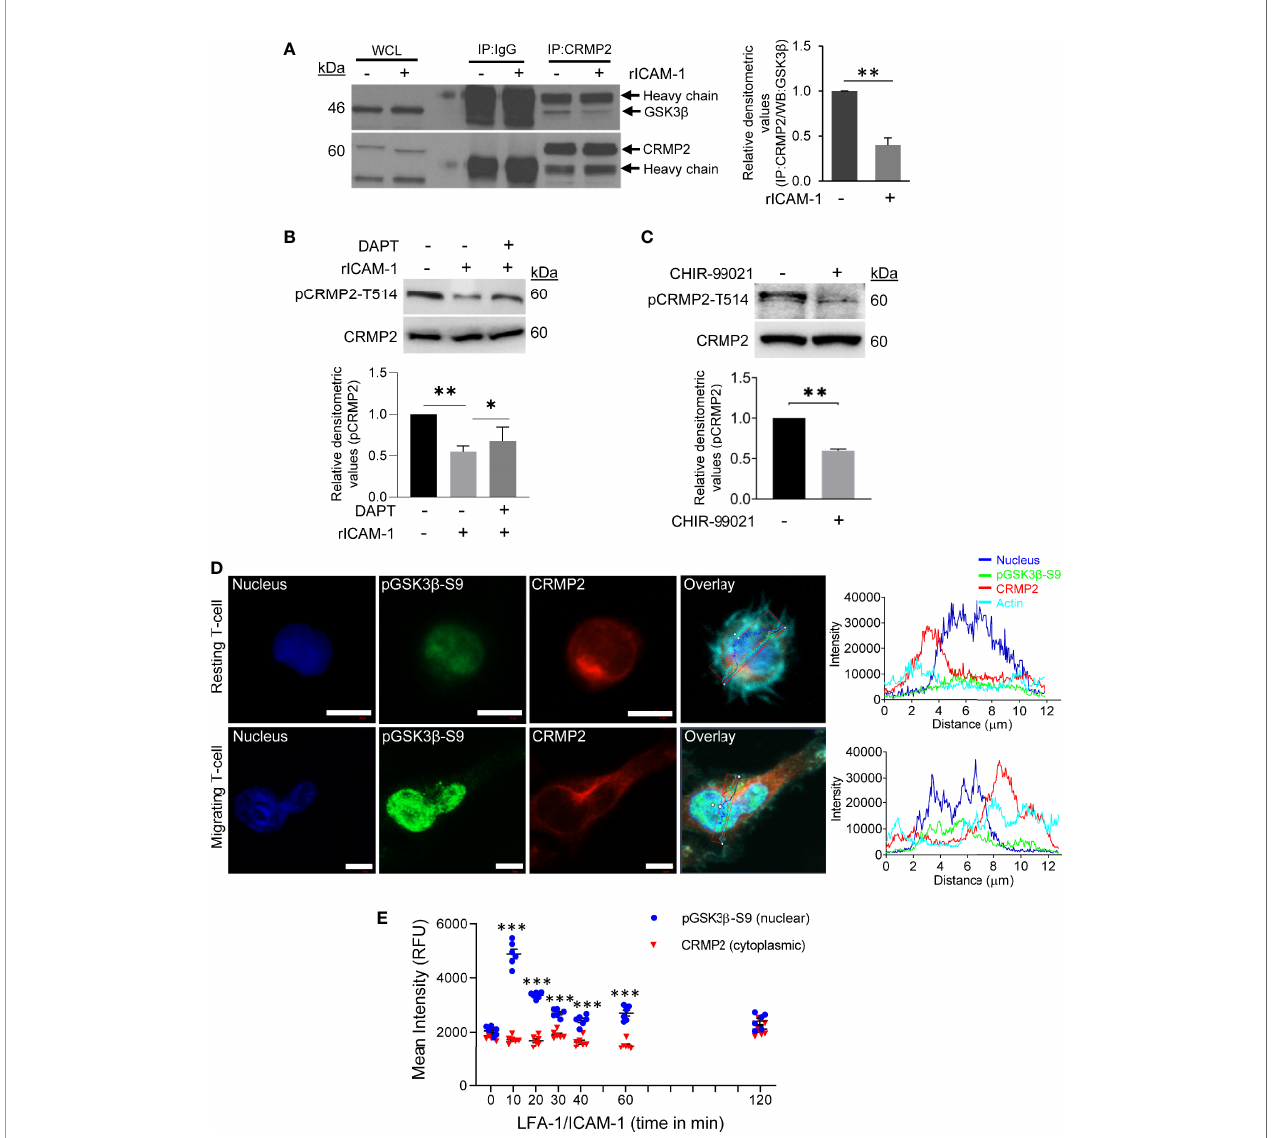
FIGURE 4 | GSK3 b -CRMP2 interactions in motile T-cells. (A) Human primary T-cells were stimulated to migrate on rICAM-1-coated plates for 30 min and lysed. Cellular lysates from unstimulated or LFA-1/ICAM-1-stimulated T-cells were immunoprecipitated ( IP ) with anti-CRMP2 and Western immunoblotted for GSK3 b and CRMP2. The amounts of GSK3 b co-precipitating with CRMP2 were quanti fi ed by densitometry analysis (mean ± SEM). (B) Human primary T-cells, untreated or pre- treated with 10 m M DAPT, were stimulated to migrate on rICAM-1-coated plates for 30 min and lysed. (C) Human primary T-cells were treated with 5 m M CHIR- 99021 or an equivalent amount of DMSO (solvent control) for 2 h and lysed. Cellular lysates in “ B ” and “ C ” were Western immunoblotted for pCRMP2-T514 and total CRMP2. The relative expression levels of pCRMP2-T514 were quanti fi ed by densitometry analysis (mean ± SEM). (D) Resting and LFA-1-stimulated migrating HuT78 T-cells were immunostained with anti-pGSK3 b -S9/Alexa Fluor ® 488 ( green ), anti-CRMP2/Alexa Fluor ® 568 ( red ), Phalloidin-Alexa Fluor ® 647 (actin, cyan ) and Hoechst (nucleus, blue ), and then imaged by confocal laser scanning microscopy, 63X oil objective. Overlay images with intensity pro fi les (replotted using the GraphPad Prism software) of nucleus, pGSK3 b -S9, CRMP2 and actin are shown. Scale bar = 5 m m. (E) T-cells (2×10 4 cells/per well) were allowed to migrate on rICAM-1-coated 96-well plate for multiple time-points up to 2 h and fi xed. Cells were stained for CRMP2 or pGSK3 b -S9 and imaged by an automated IN Cell Analyzer 2200 microscope using 20X objective (6 fi elds/well). Cytoplasmic and nuclear intensities of CRMP2 and pGSK3 b -S9, respectively, from >500 cells/well were subsequently analysed cell-by-cell by the IN Cell Investigator software. Each dot represents mean intensity values from >500 cells. Data represent at least three independent experiments. *p < 0.05; **p < 0.01; ***p < 0.001 compared to resting T-cells (0 min) control; RFU, relative fl uorescent